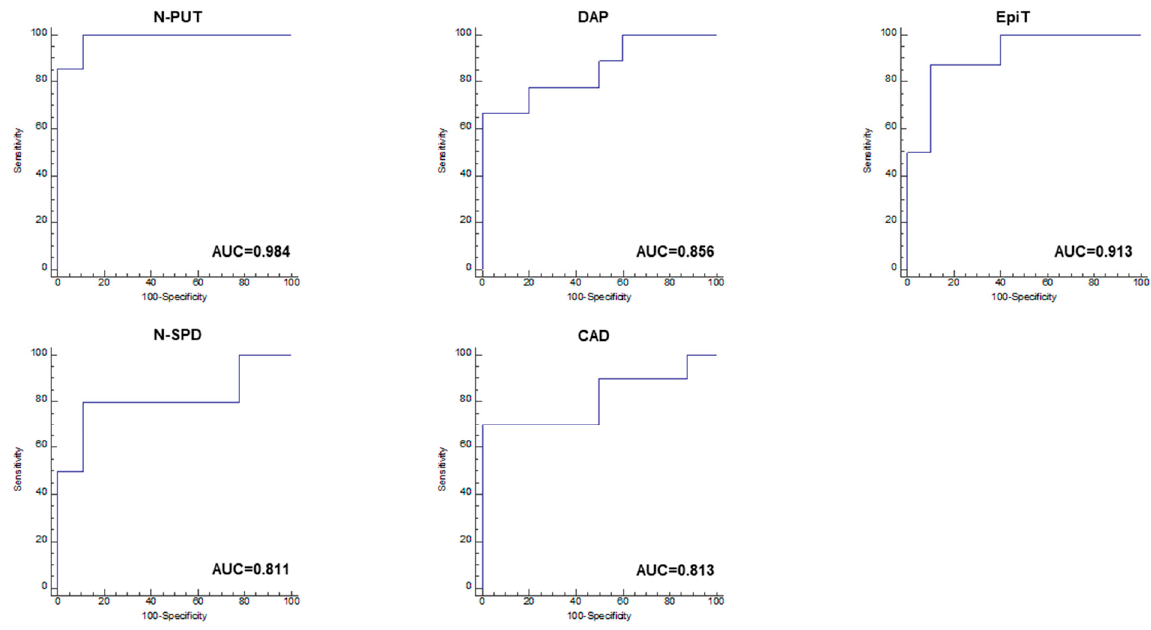
Figure 4. Univariate receiver operator characteristic (ROC) curve analyses for predicting biomarker performance in serum samples from treated breast cancer patients. Typical ROC curve plots of potential biomarkers with high-performance prediction are shown; several metabolites with AUC > 0.8 were observed. The ROC value of each metabolite was as follows: N-PUT, 0.984; N-SPD, 0.811; DAP, 0.856; CAD, 0.813; EpiT, 0.913 (N-PUT: N -acetyl putrescine; N-SPD: N -acetyl spermi-